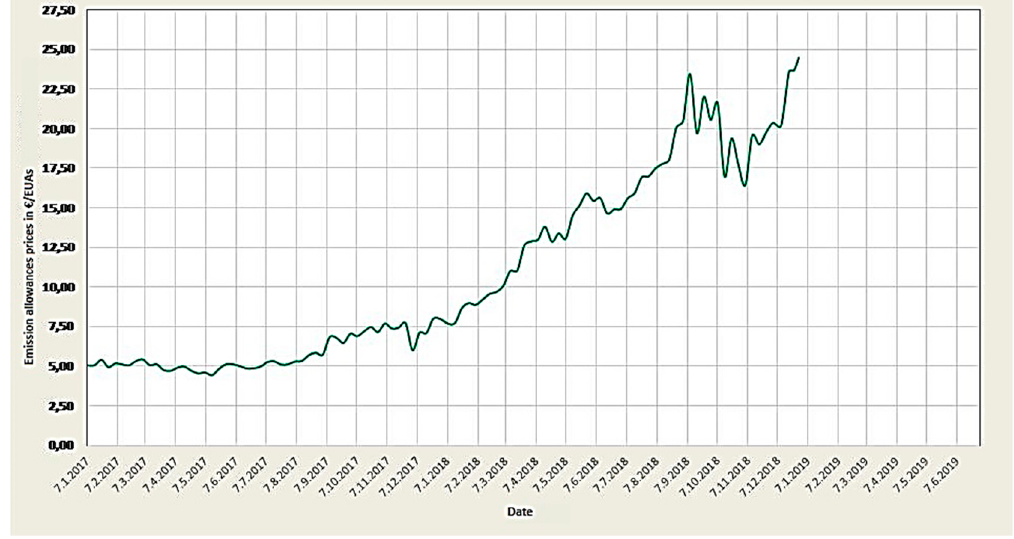
Figure 6. End user prices of emission allowances for greenhouse gases (Source: [34]).